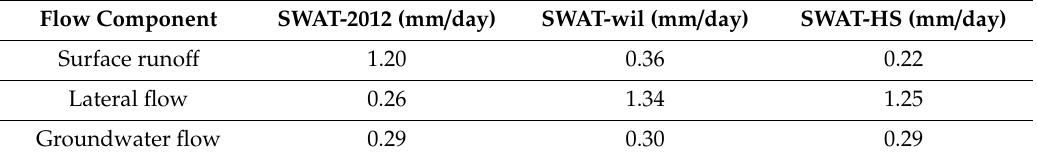
Figure 4. Simulated surface runoff contributing areas (VSAs) as indicated by average surface flows over 250 mm a –1 component by SWAT-2012, SWAT-wil, and SWAT-HS for the Town Brook watershed.